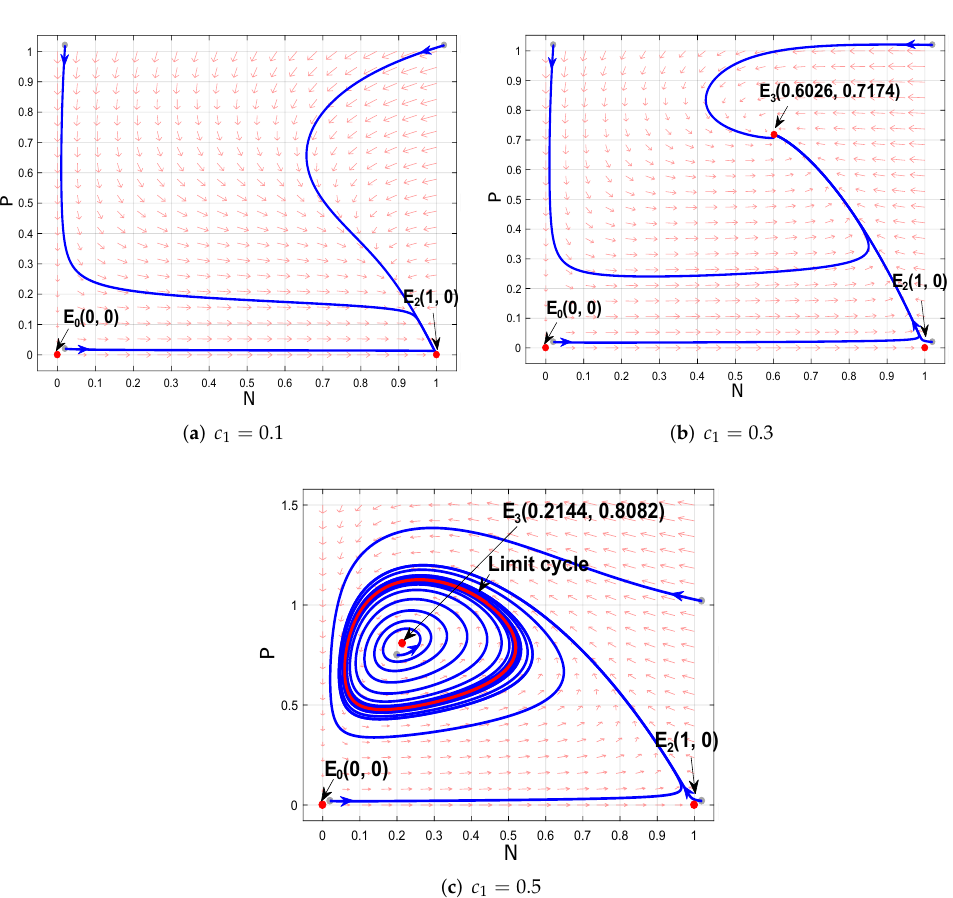
Figure 4. Phase Portraits of the system (3) with parameter values as in Table 2 and ( a ) c 1 = 0.1, ( b ) c 1 = 0.3, and ( c ) c 1 =